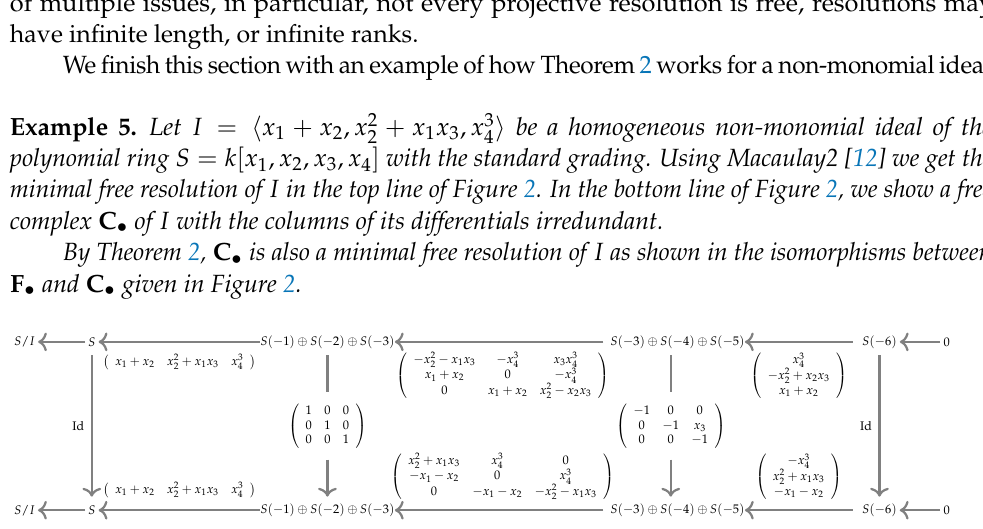
Figure 2. Two minimal free resolutions of the ideal I = (cid:104) x 1 + x 2 , x 2 between